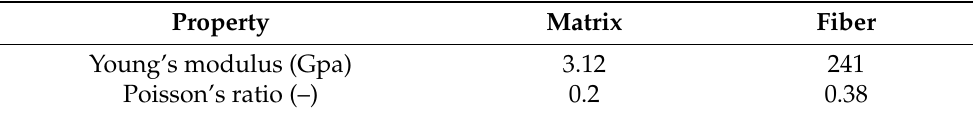
Table 1. Elastic properties of matrix and transverse isotropic fiber for the training phase of the developed ANN.